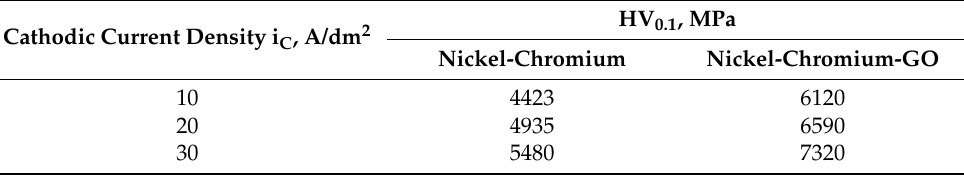
Table 2. Influence of cathodic current density on the microhardness HV 0.1 , MPa of nickel–chromium alloys and CEC